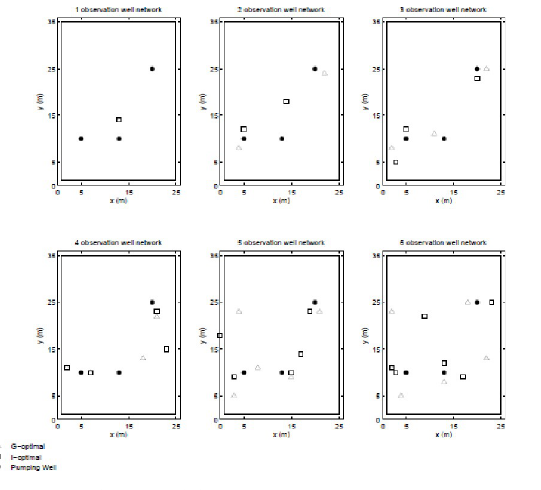
Fig 5. G- and I-optimal